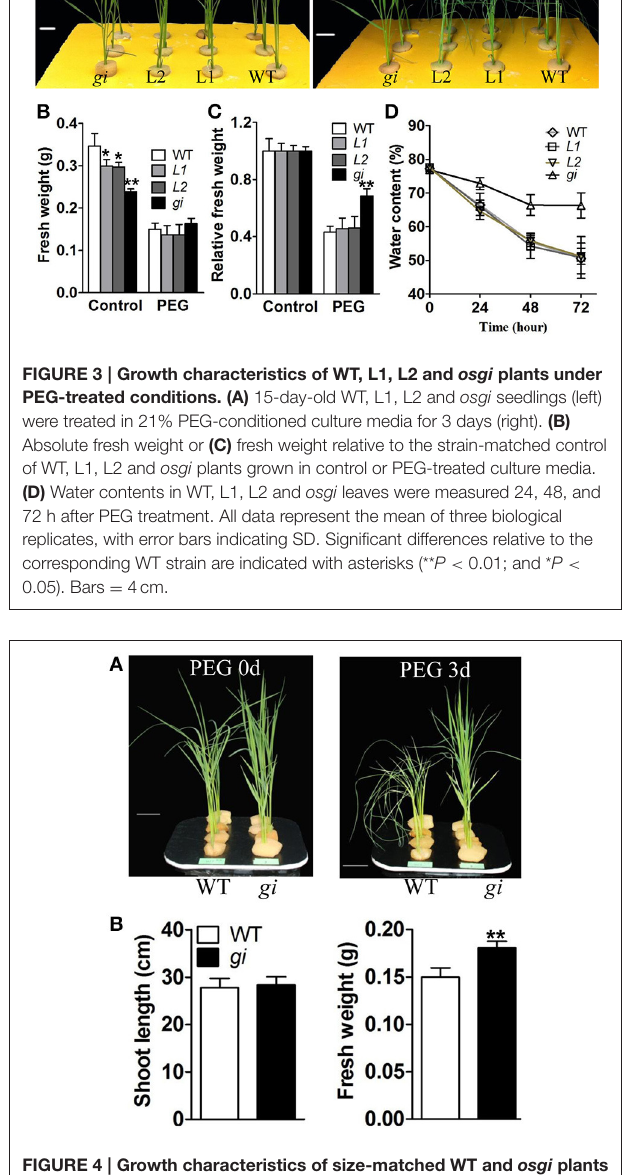
FIGURE 4 | Growth characteristics of size-matched WT and osgi plants in response to PEG treatment. (A) 11-day-old WT and 14-day-old osgi seedlings, displaying the same plant height, were treated with 21% PEG condition for 3 days. (B) Shoot length and fresh weight of WT and osgi plants in ( A ). All data represent the mean of three biological replicates with error bars indicating SD. Significant differences relative to the corresponding WT strain are indicated with asterisks ( ** P < 0.01). Bars =